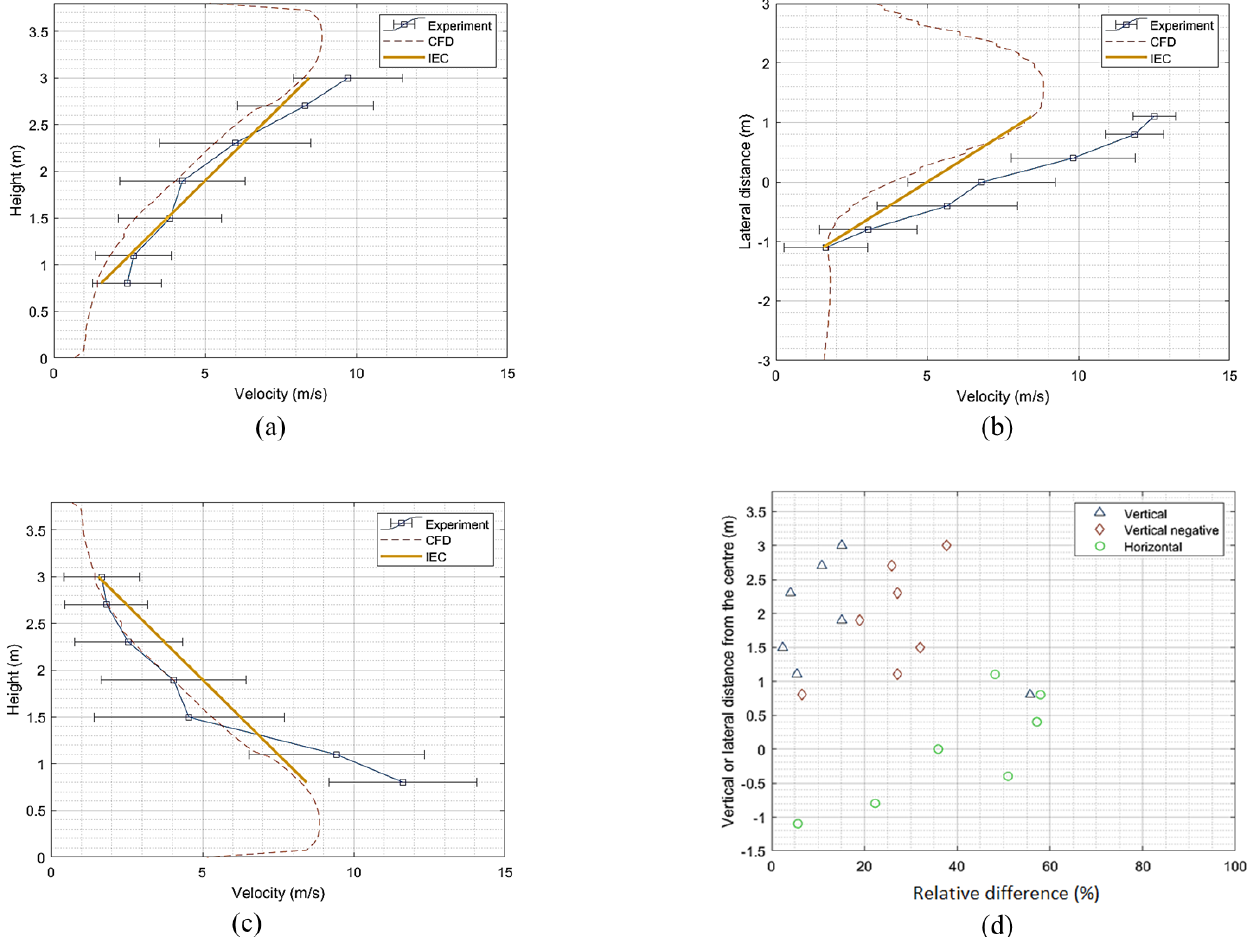
Figure 10. CFD predictions vs. experiment data for steady (a) vertical shear, (b) horizontal shear and (c) negative vertical shear. (d) The relative disconformity between the three steady shear experiments and IEC